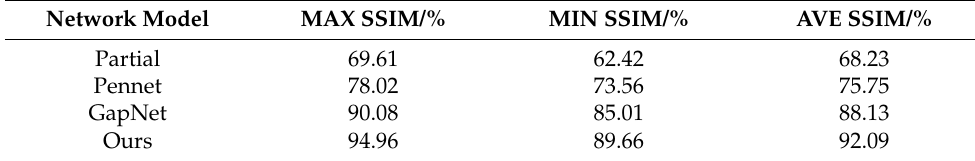
Table 2. Comparison of SSIM